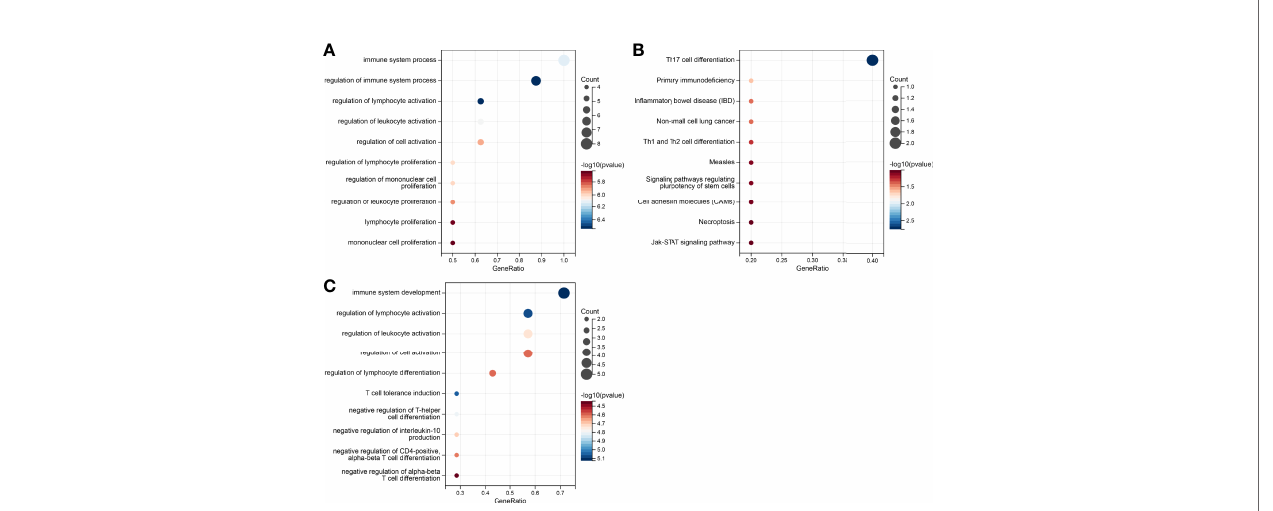
FIGURE 7 | Gene set enrichment analysis of the genes in the prognostic risk models. (A) GO enrichment in the survival-related model. (B) KEGG pathways in survival-related model. (C) GO enrichment in the relapse-related model.